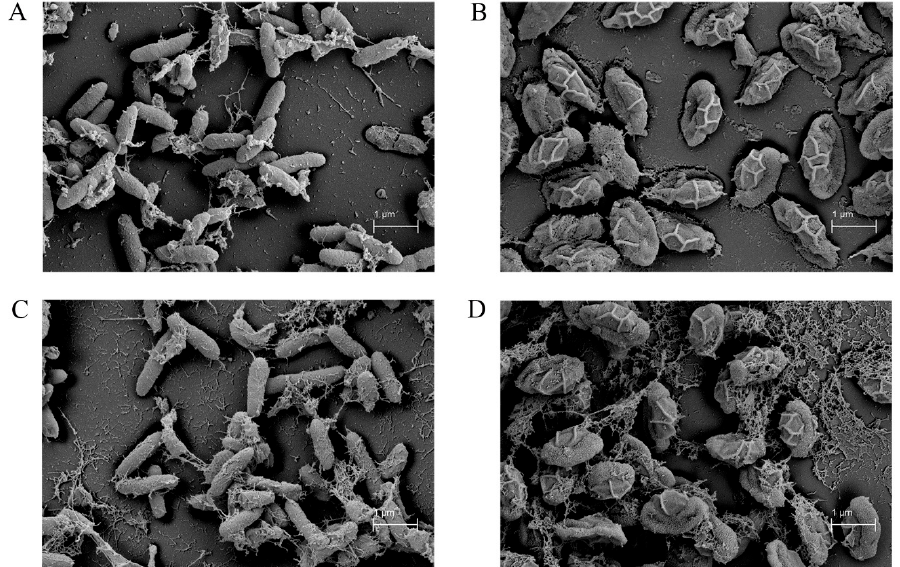
Figure 4. SEM micrographs for ( A ) vegetative cells of Brevibacillus sp. SPR-20, ( B ) spores of Brevibacillus sp. SPR-20, ( C ) vegetative cells of its UV-treated mutant (M201), and ( D ) spores of its UV-treated mutant (M201). The vegetative cells and spores were obtained by culture on the MH agar for 1 and 7 days, respectively, at 30 °C. Table 5. Antibiotic susceptibility of Brevibacillus sp. SPR-20 and its mutant strain (means ± SD; n = 3).